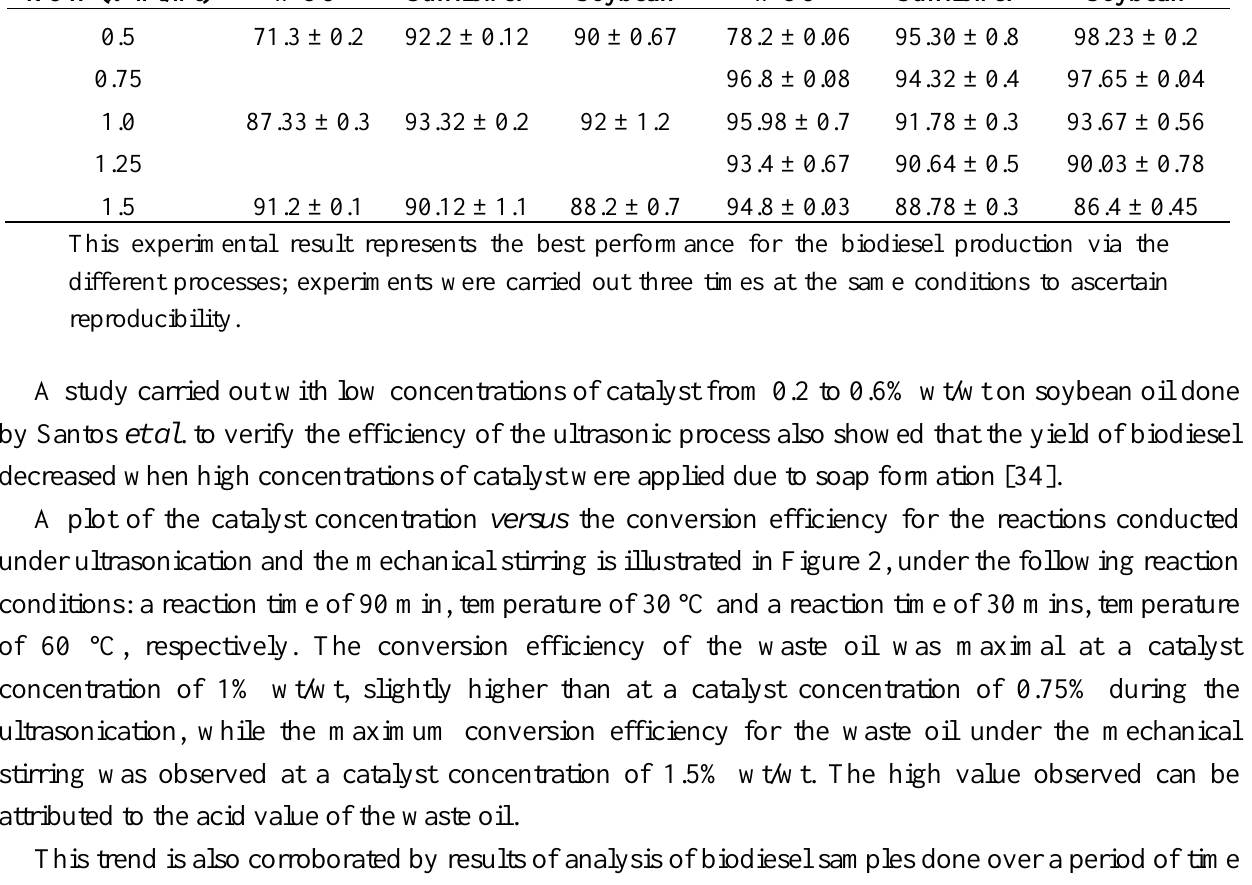
Table 2. Effect of catalyst concentration on FAME yield via the mechanical and ultrasonic process. Catalyst Mechanical Stirring Ultrasonication Concentration (600 rpm) Yield (%) (24 kHz) Yield (%) KOH (%wt/wt) WCO Sunflower Soybean WCO Sunflower